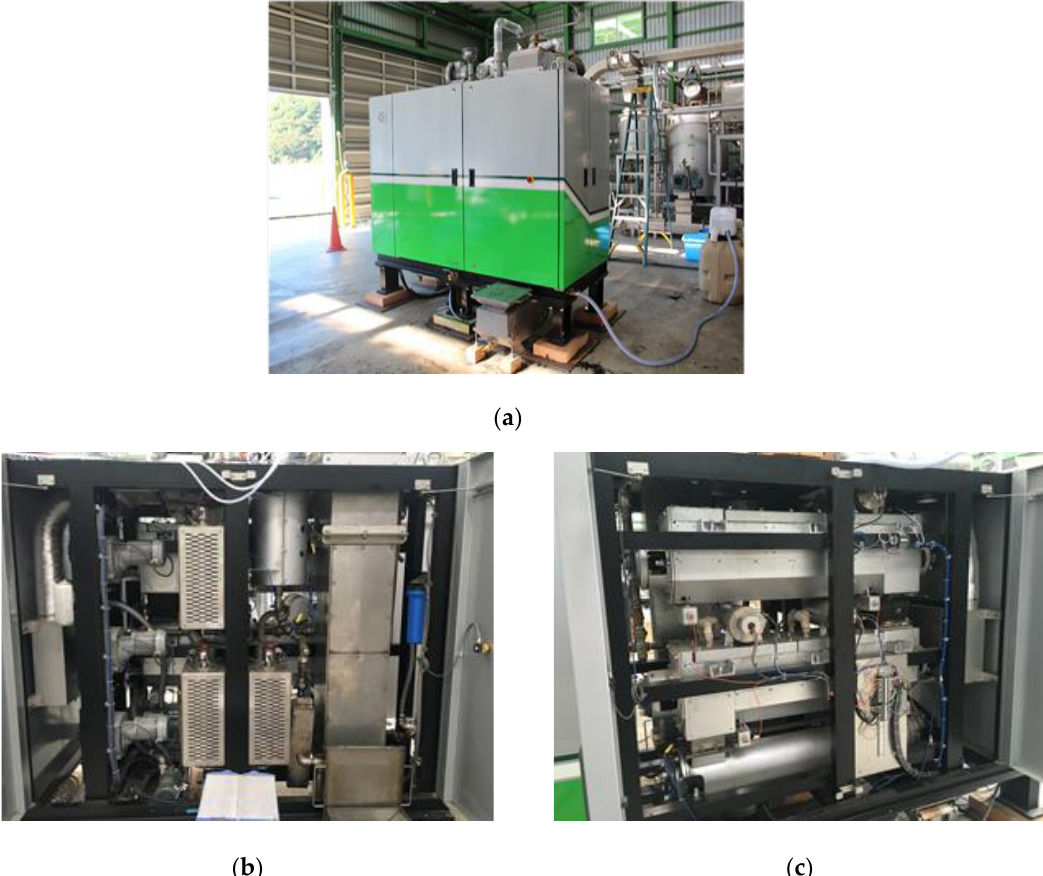
Figure 3. Torrefaction equipment: ( a ) appearance, ( b ) inside of the superheated steam torrefaction tester (front), and ( c ) inside of superheated steam torrefaction tester (back).